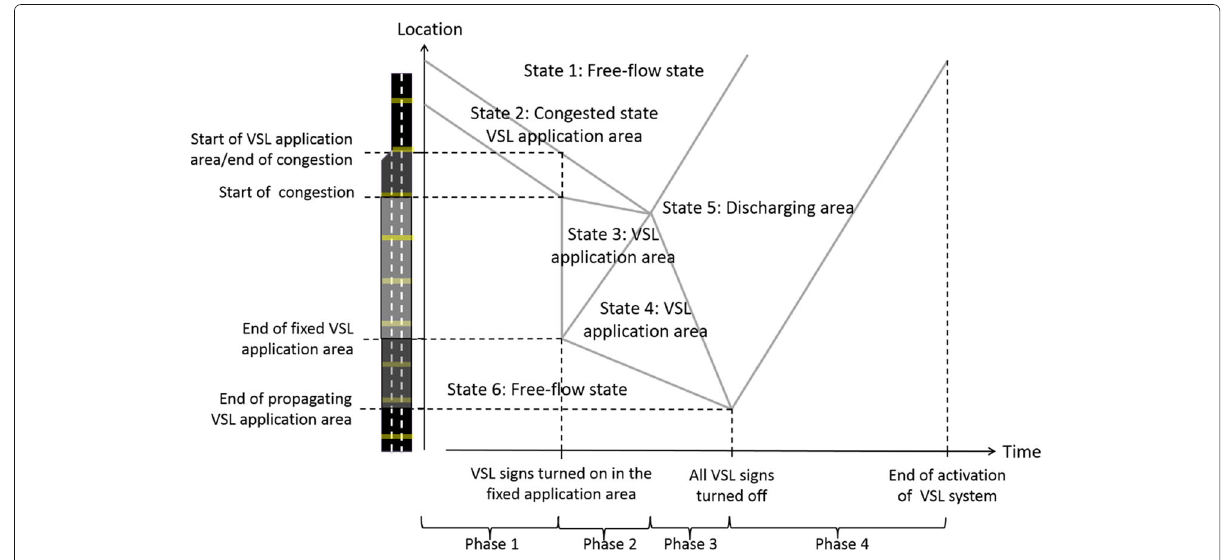
Fig. 1 Illustration of the different states and phases in the SPECIALIST